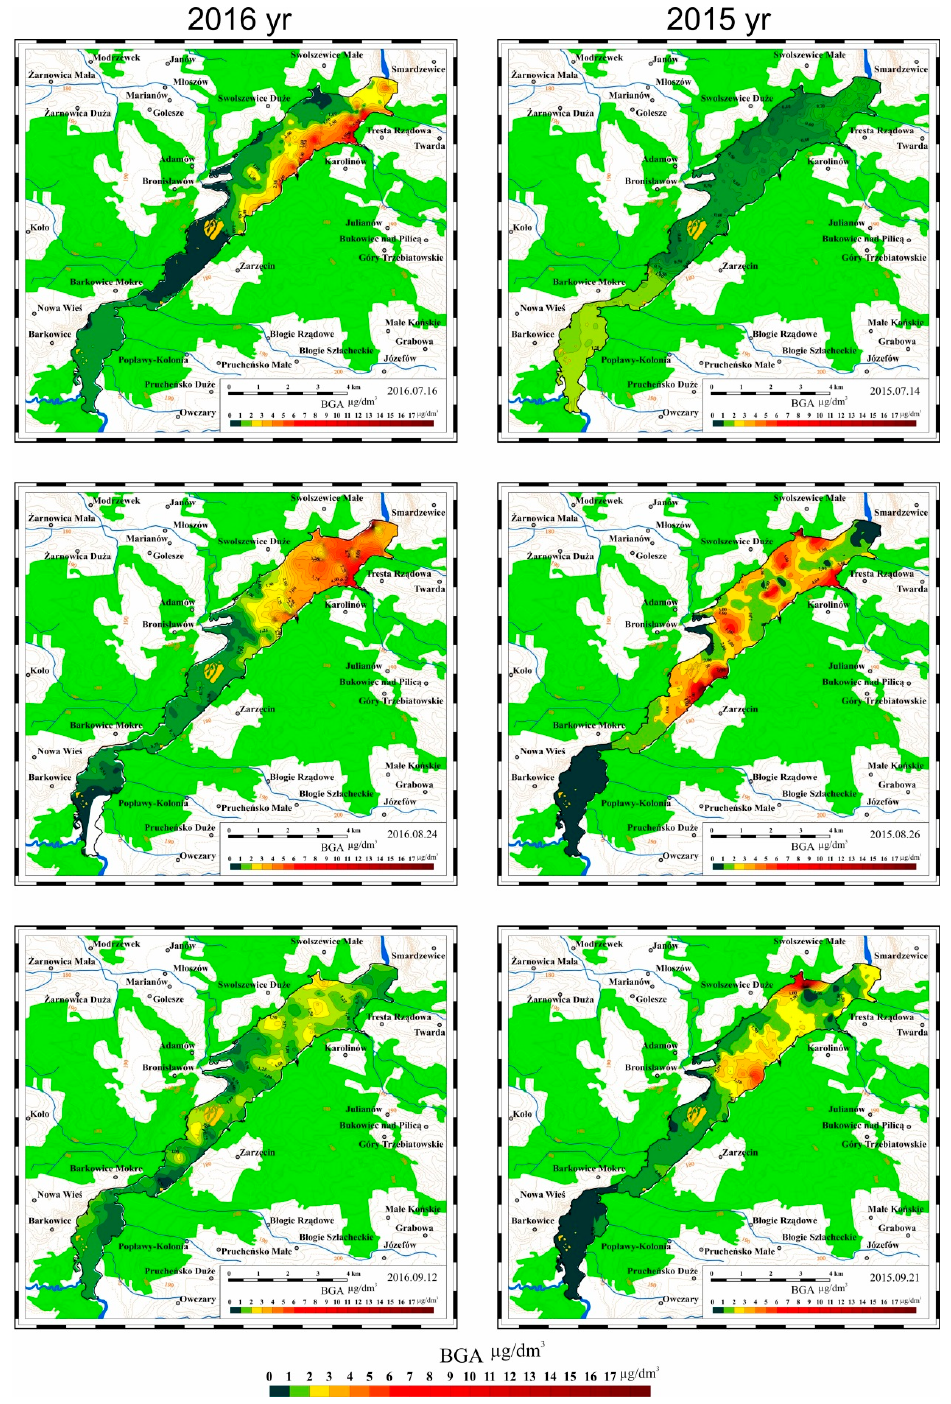
Figure 10. Spatial distribution of BGA (blue-green algae) concentration in the Sulejow Reservoir between June and September 2015 and